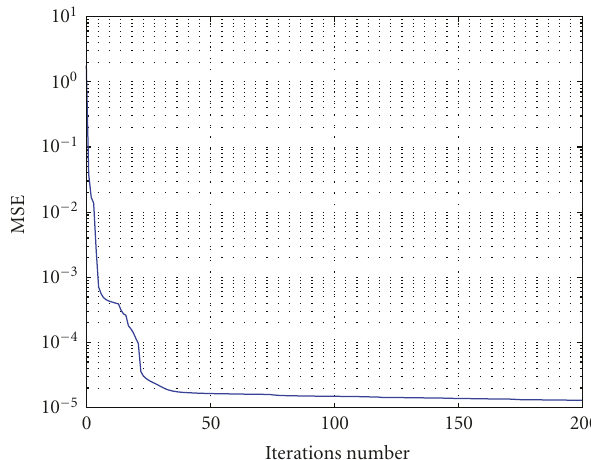
Figure 13: MSE versus iterations number for 64 carriers and 16- QAM OFDM, PD(2,9,2).